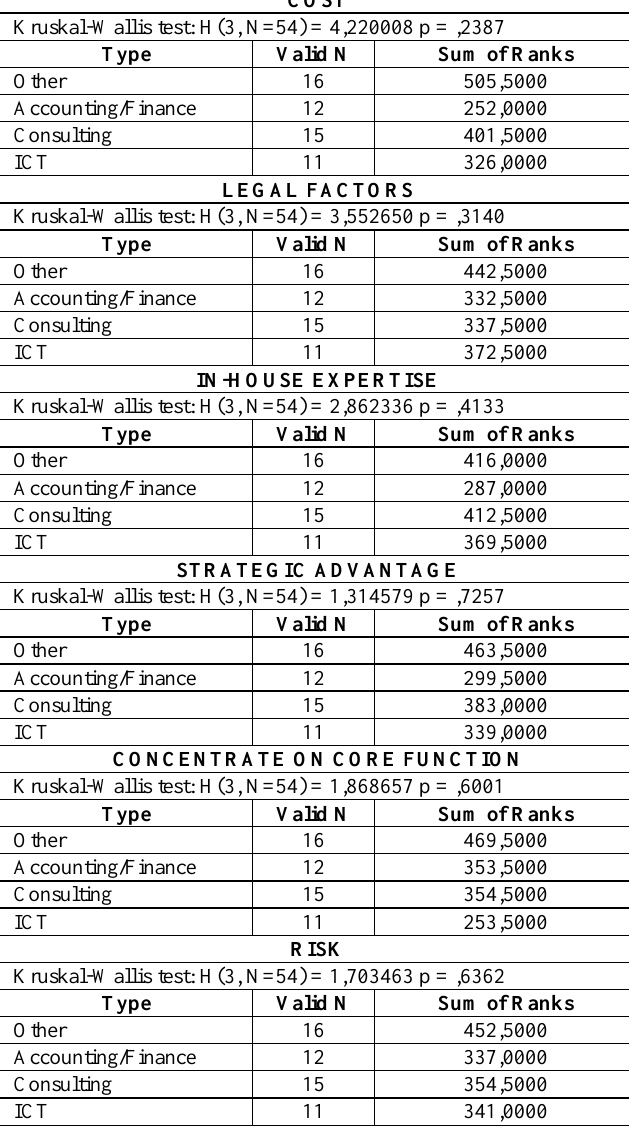
Table 10: Chi-Squared results for size vs form